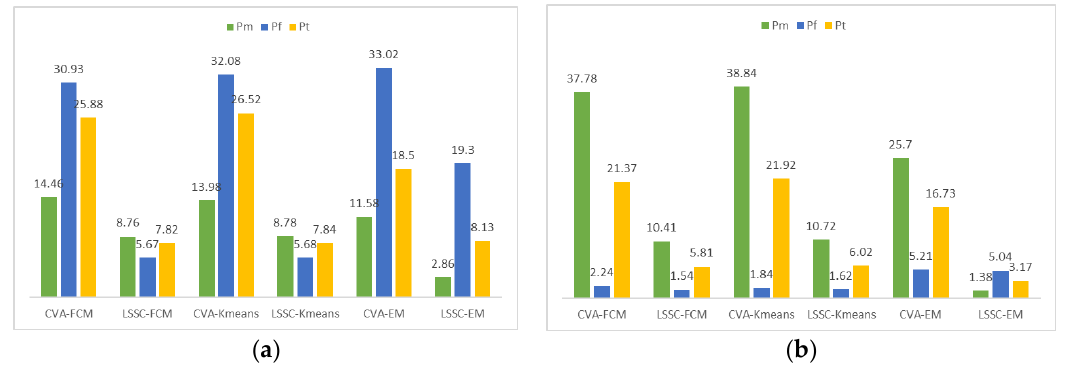
Figure 12. The accuracies of various methods in the experiments in terms of P m , P f and P t . ( a ) the accuracy of the first data set; ( b ) the accuracy of the second data